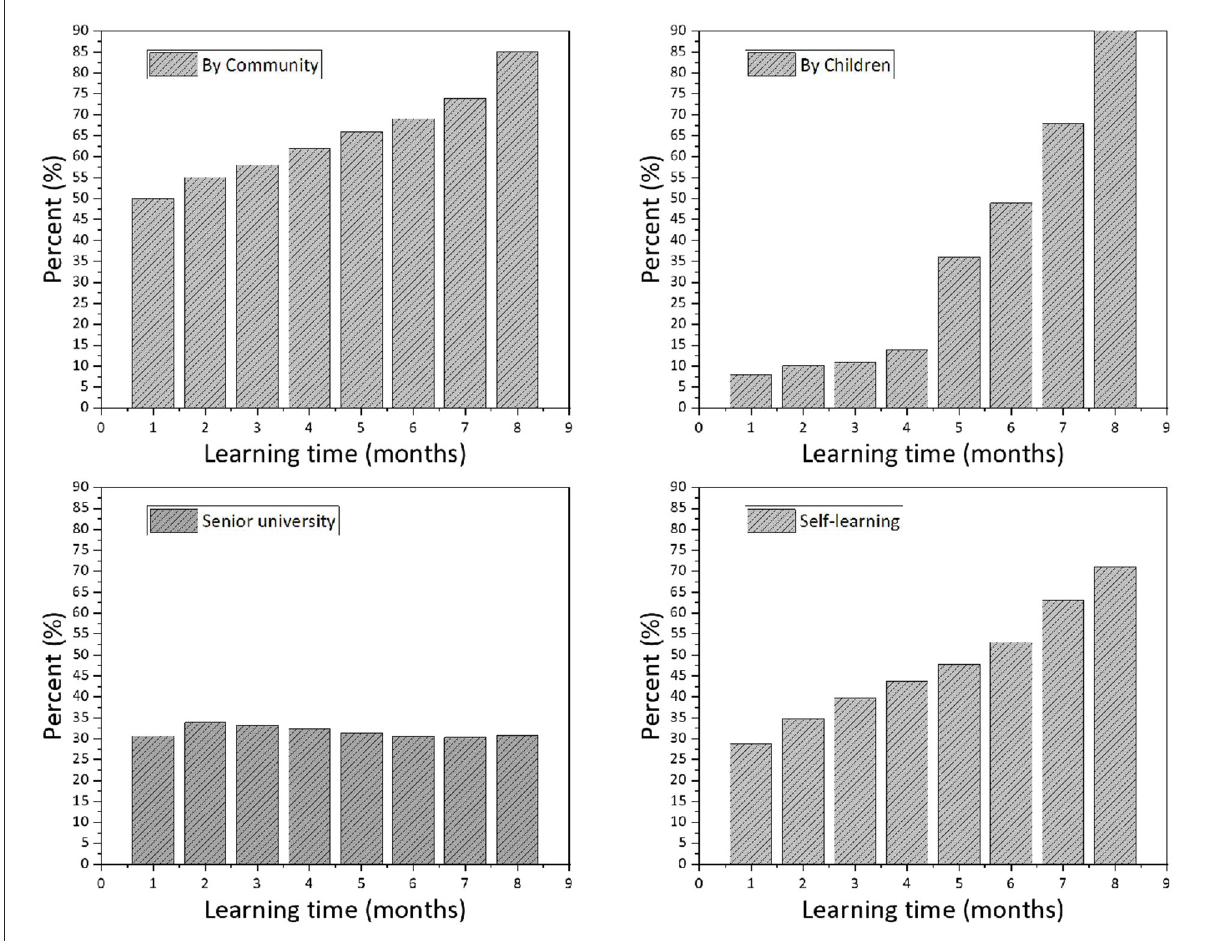
FIGURE5 Smartphone learning channels for older